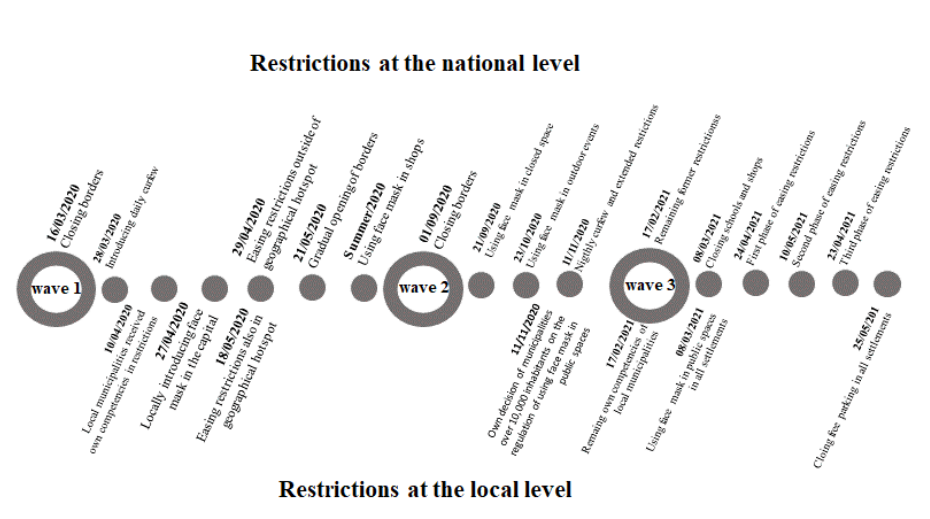
Figure 12: Restrictions regarding the COVID-19 epidemic waves in Hungary and their spatial relevance (04 March 2020 – 11 June 2021) Masks were mandatory in all public spaces after 11 November. Still, municipalities also received the decree to make detailed local rules for public mask mandate in settlements with populations over